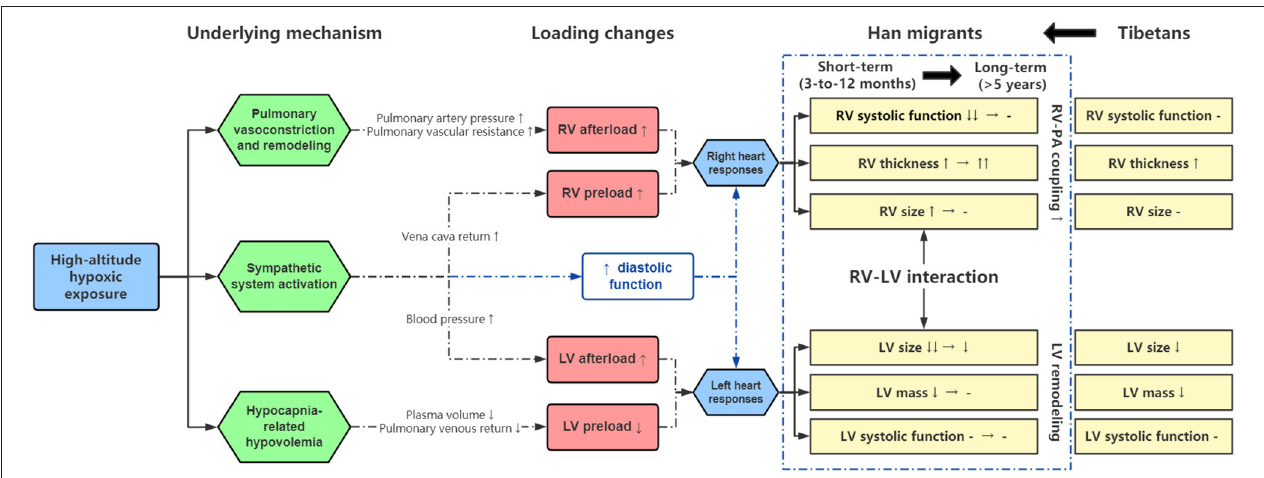
Conventional and Doppler data